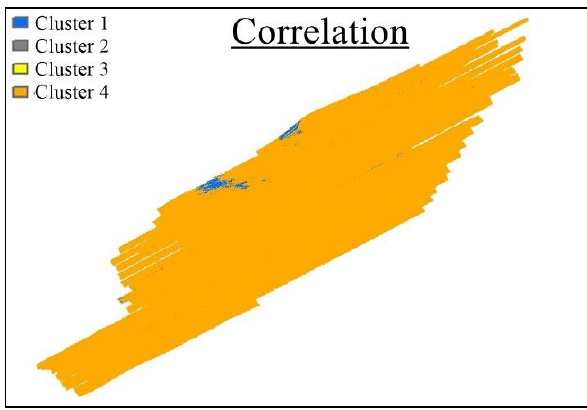
Figure 3: Sediment classes produced using Angular Range Analysis (ARA) and used for ground truthing